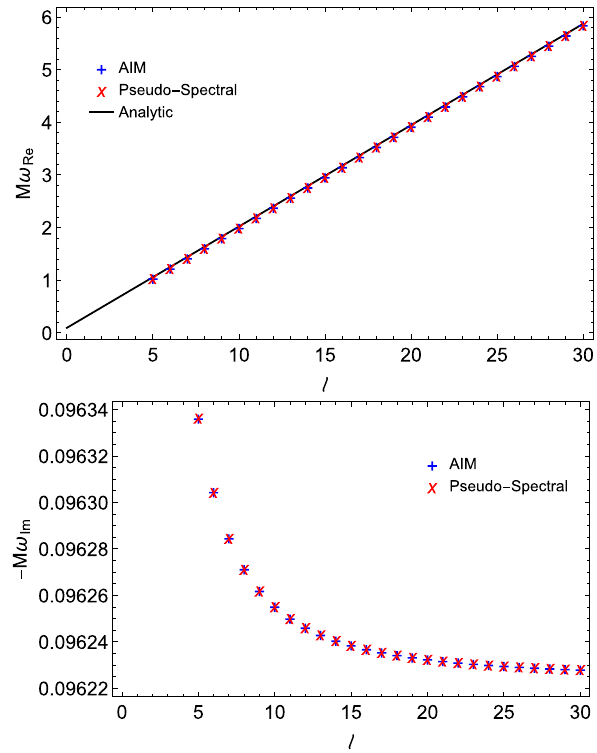
Fig. 1 The real (top panel) and imaginary (bottom panel) parts of the frequency as a function of (cid:6) for the scalar s = 0 field in the case n = 0, the fundamental mode. The crosses ( + ) represent the AIM results, the exes (x) indicate the pseudo-spectral, while the solid black line in the top panel is the plot of the function M ω Re given in Eq.